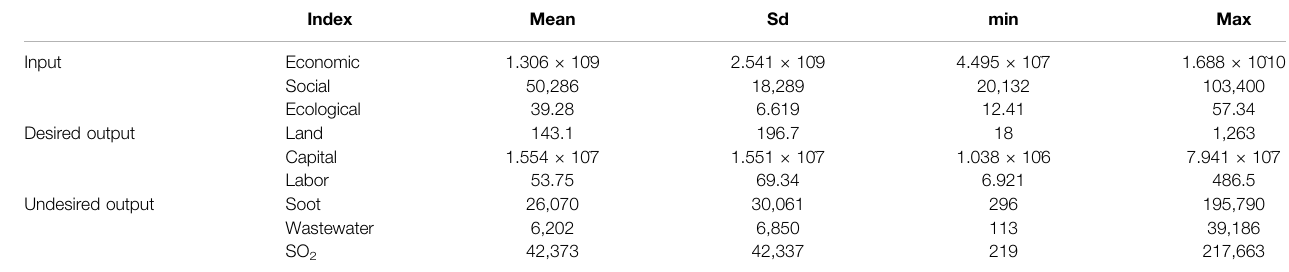
TABLE 3 | Descriptive statistics of input-output index (N =